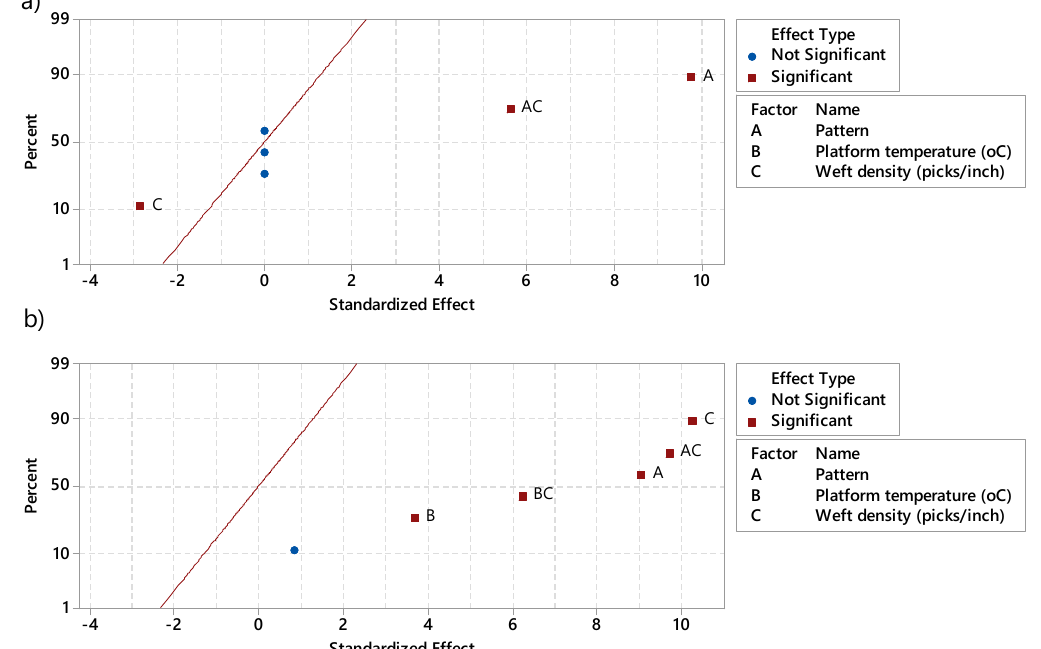
Figure 9. Effect of (A) pattern, (B) platform temperature in °C, and (C) weft density in picks/inch on ( a ) pore size of the fabric prior to 3D printing process and ( b ) 3D-PPOT materials after 3D printing process, obtained through pareto analysis of Minitab 17. AC and BC represent the interaction between the factors A and C and, B and C, respectively.